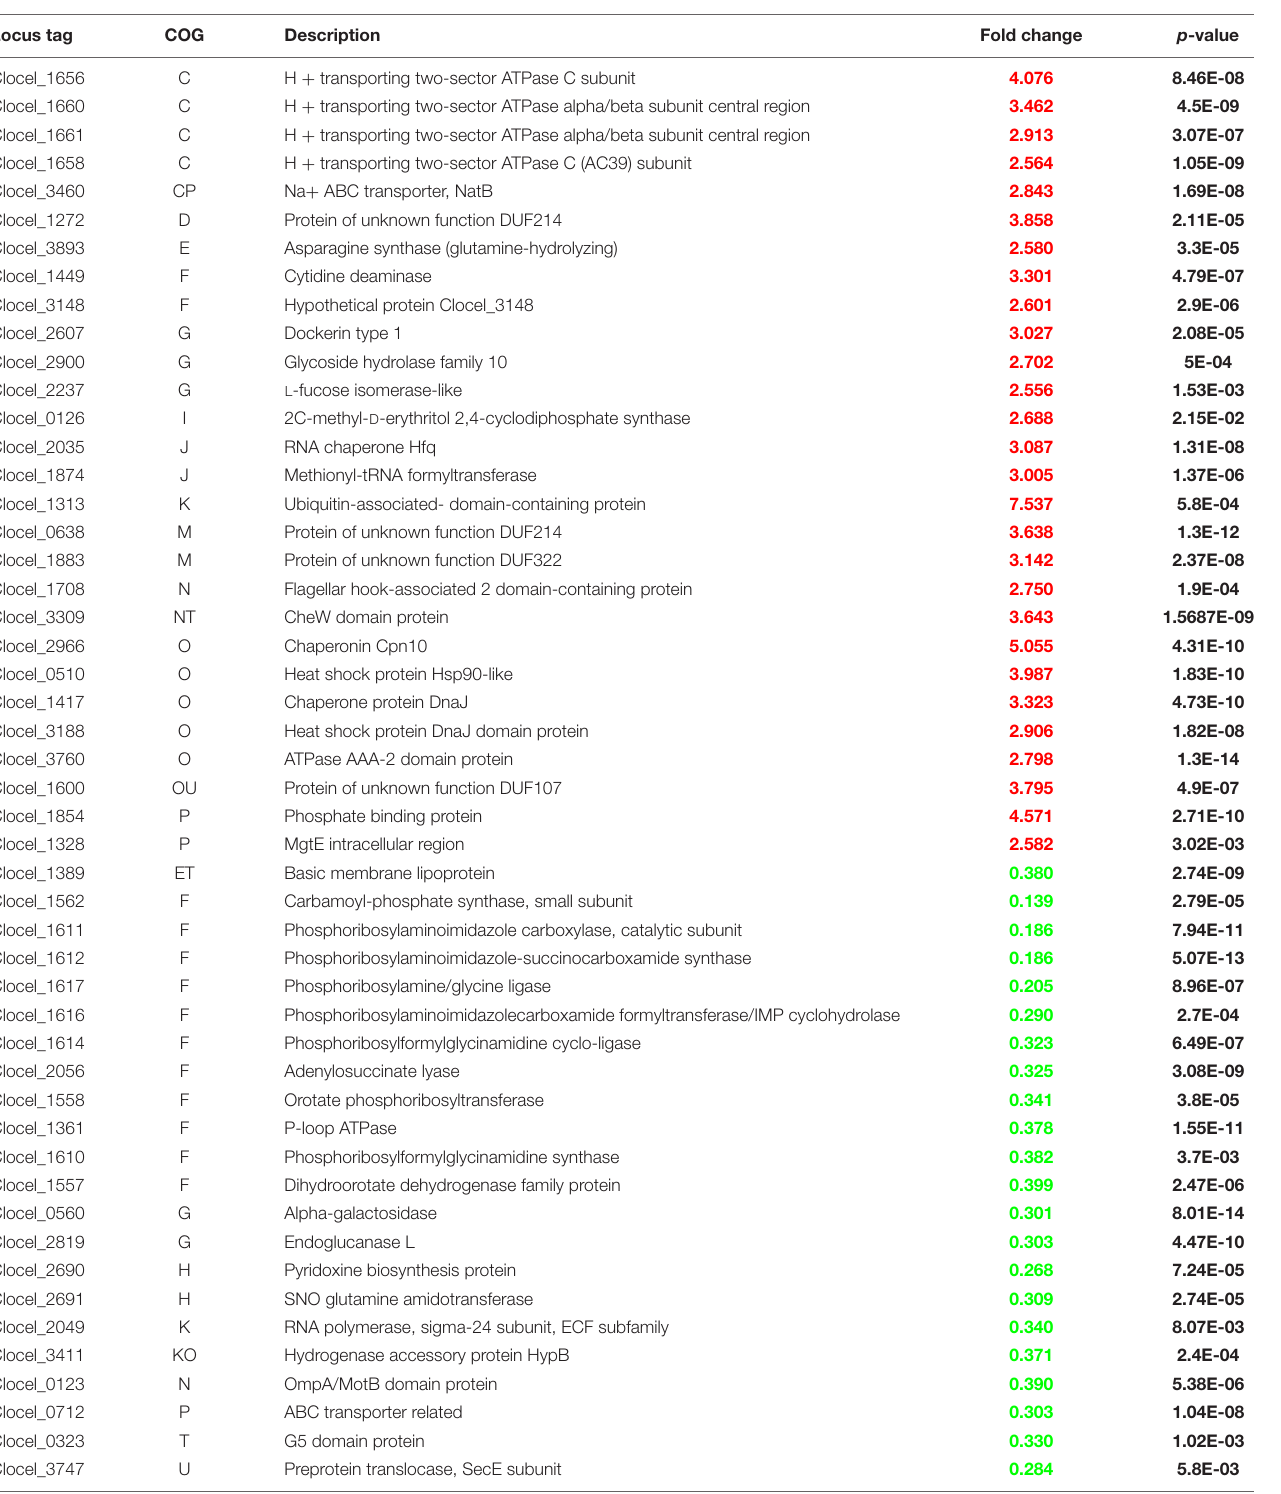
TABLE 1 | List of the most highly differentially expressed proteins quantified in the present study for each COG category. Locus tag COG Description Fold change p